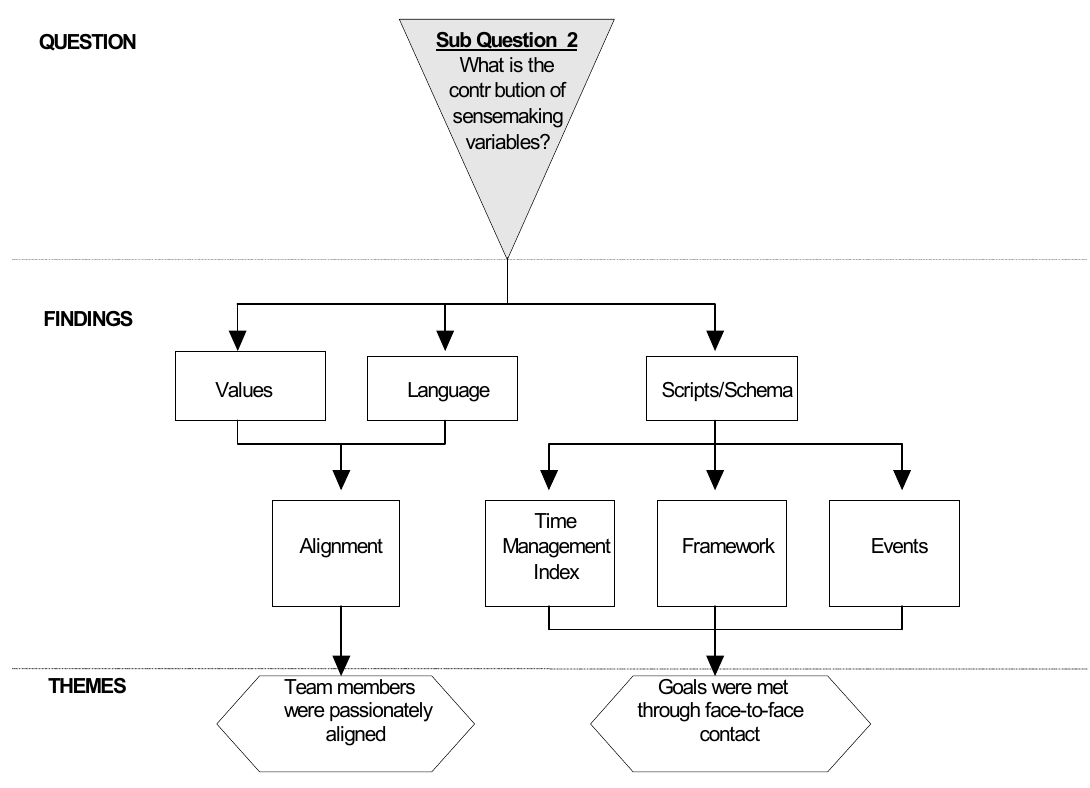
Figure 7: Subquestion 2 – findings and themes Team members also recognized the BP culture as not oriented towards mandates, creating an imperative for the KMT to engage with people to voluntarily adopt processes,